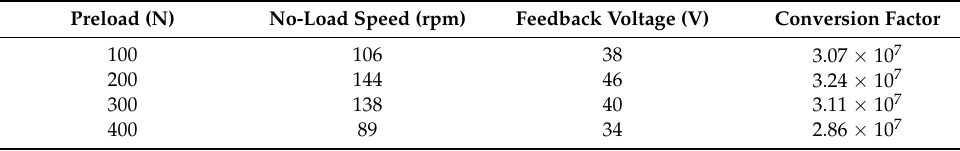
Table 2. Contact model